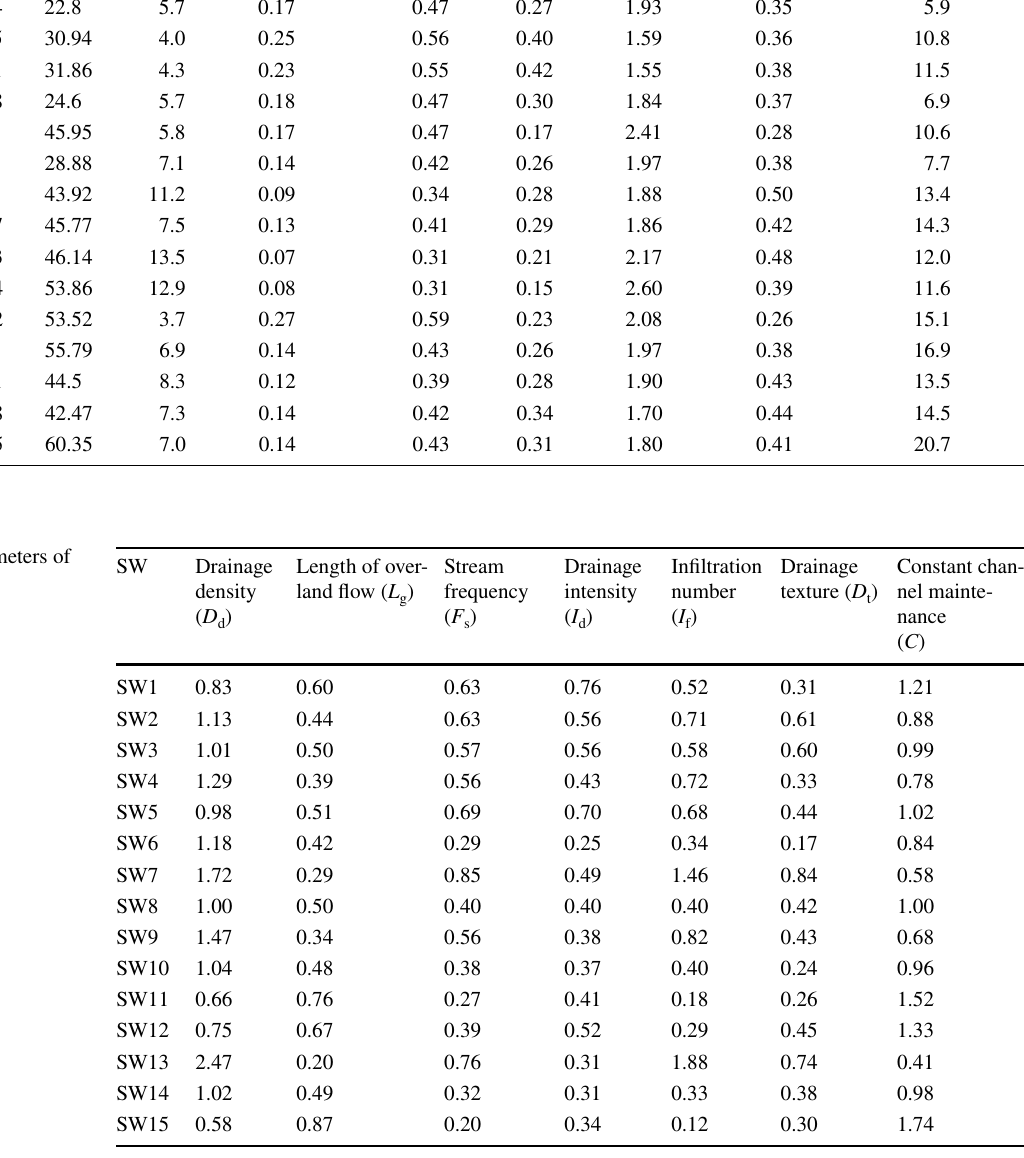
Table 4 Watershed geometry parameters SW Basin length